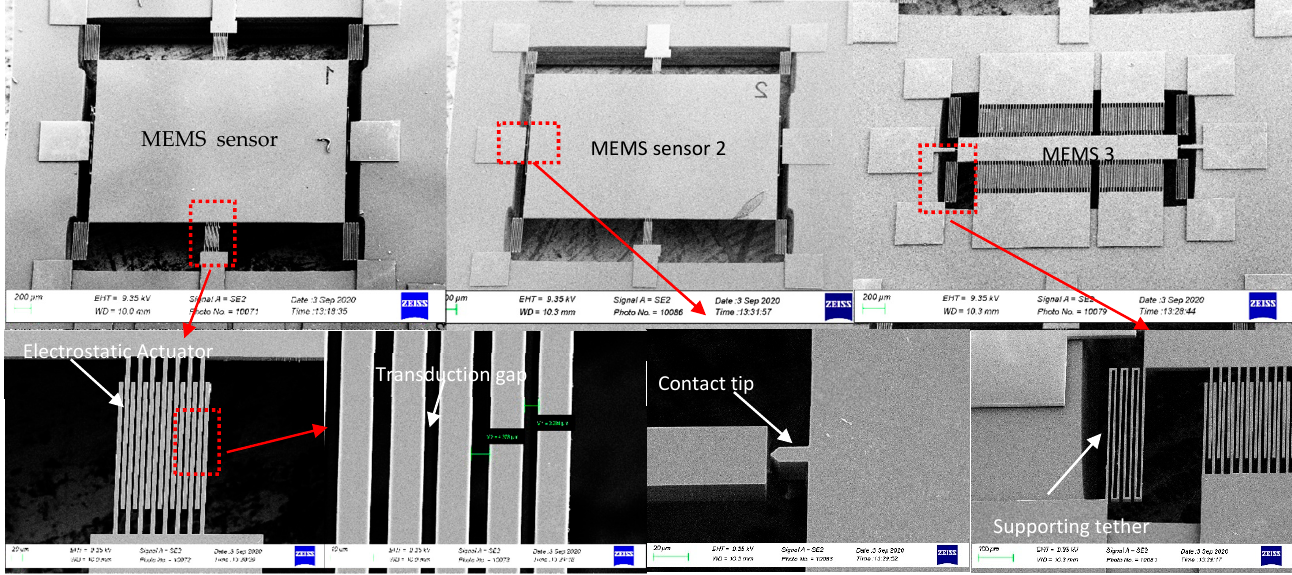
Figure 11. Scanning electron microscope (SEM) views of a fabricated MEMS CTRNN. This novel MEMS network can perform intelligent computing using only bias voltages.